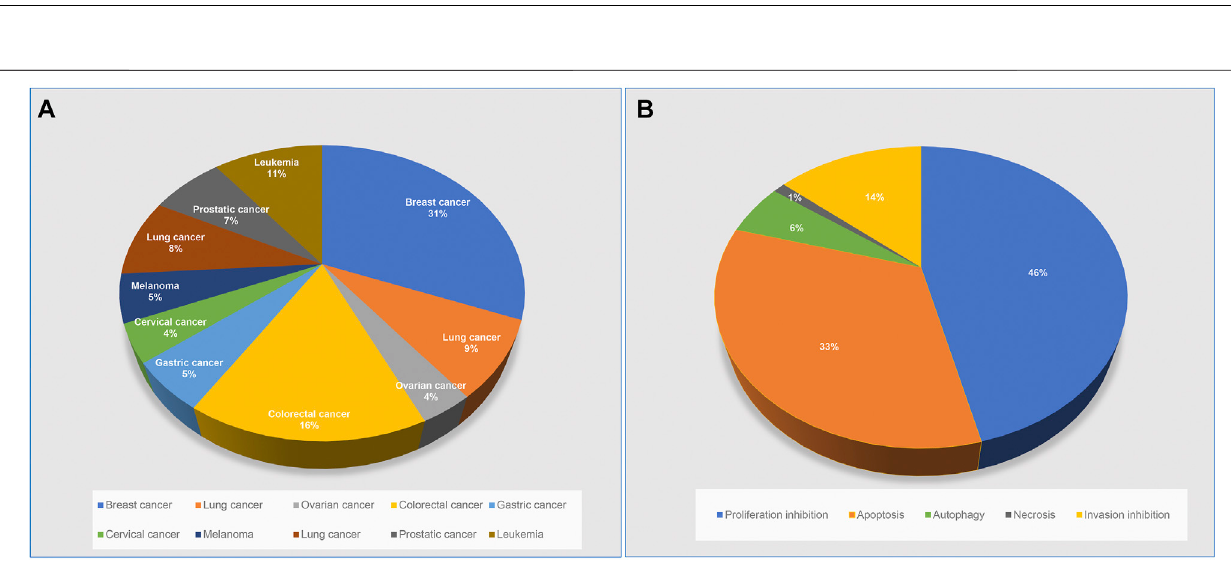
Frontiers in Pharmacology |